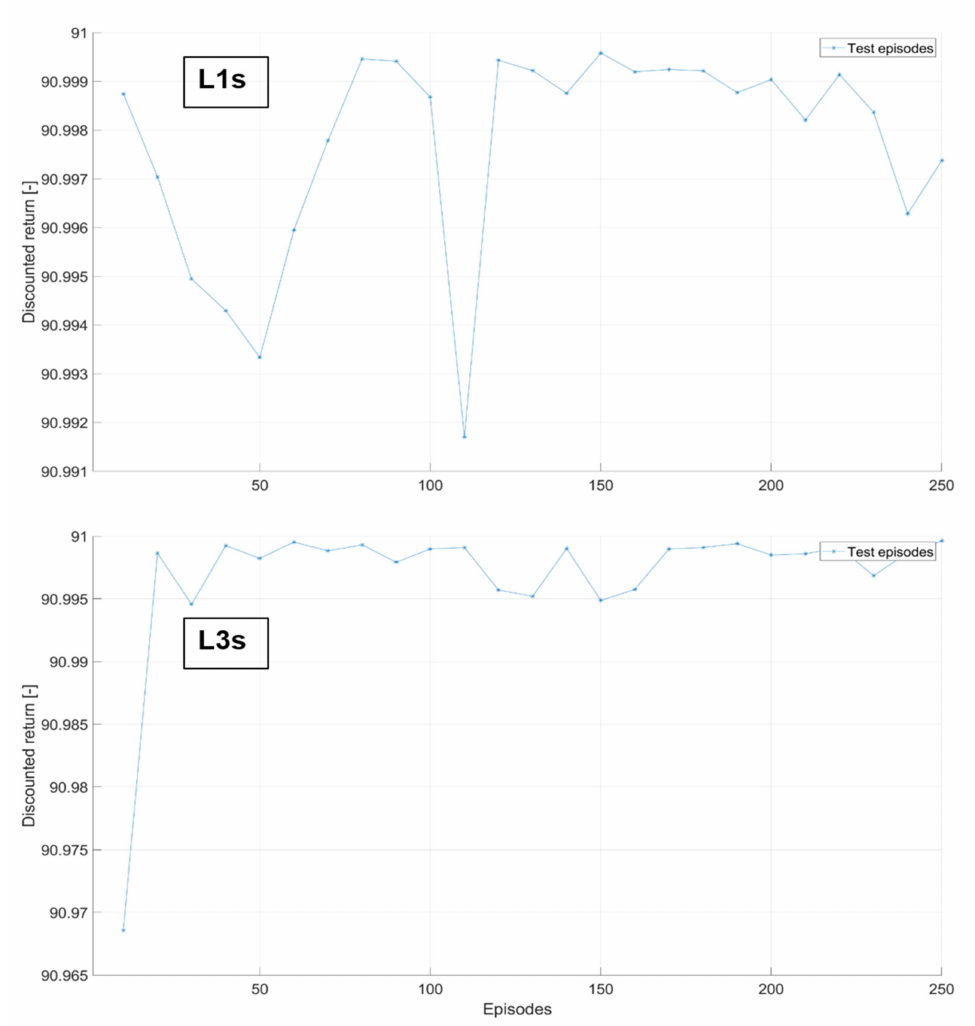
Figure 17. Comparison of the discounted return evaluated at the initial time step of the testing episodes for L1s and